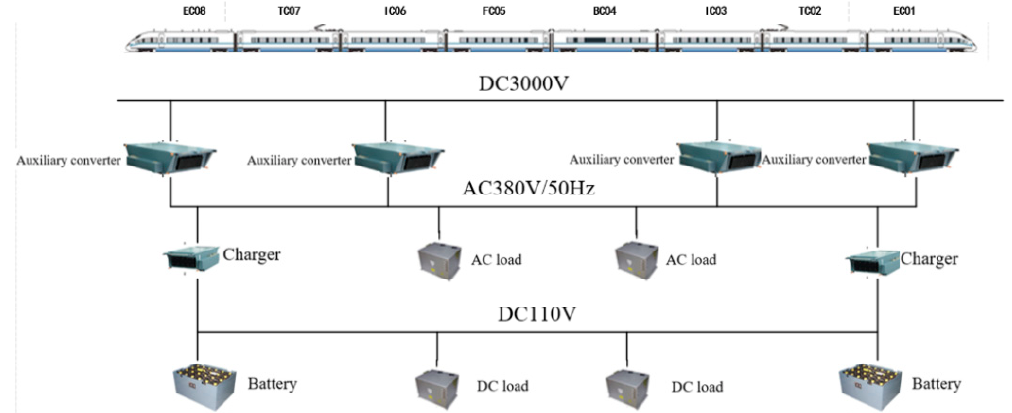
Figure 1. Simplified schematic diagram of the EMU auxiliary power supply system.